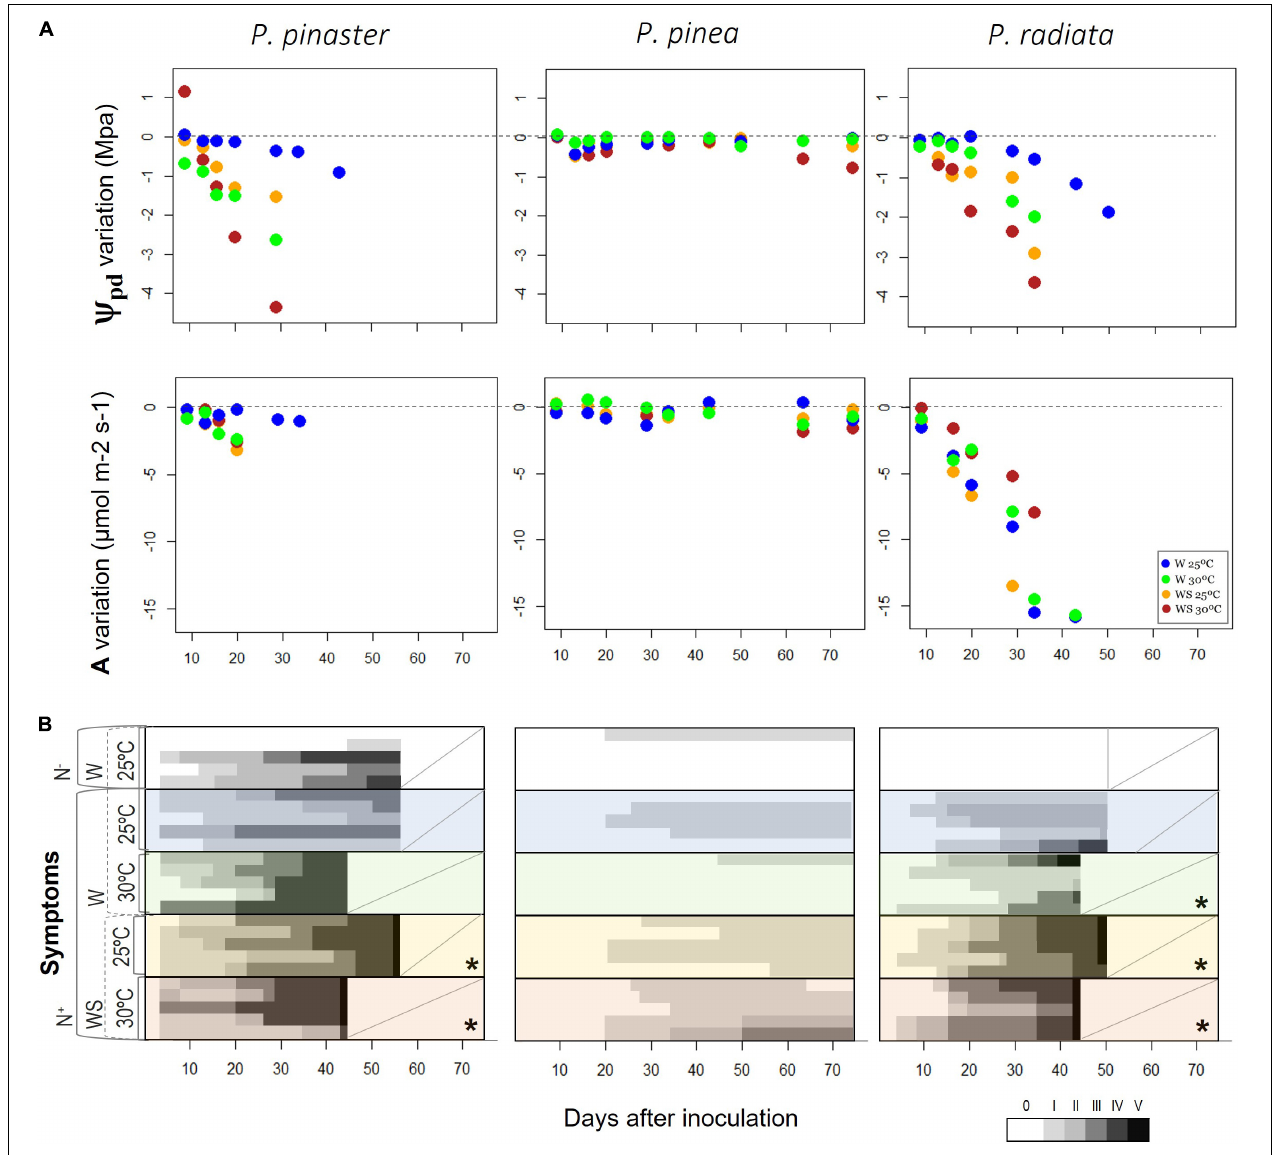
FIGURE 3 | Variation over time of main physiological variables and visible symptoms. (A) Pre-dawn water potential ( (cid:57) pd ) and carbon assimilation (A) from the controlled abiotic conditions to the respective inoculated treatment, i.e., the difference of (cid:57) pd and A between the inoculated treatments and the associated control (W25: N– vs. N+, WS25: N– vs. N+, W30: N– vs. N+, WS30: N– vs. N+) and (B) wilting symptoms after inoculation. Classification of wilting symptoms based on six scaled classes: 0 – tree without symptoms; I – < 10% brown leaves; II – 10–50% brown leaves; III – 50–80% brown leaves; IV – > 80% brown leaves; V – dead tree without leaves (Proença et al., 2010). An asterisk represents the presence of severe symptoms, with plants reaching death. A diagonal line indicates that the trial was finished, and the trees were removed. See section “Materials and Methods” for detailed information about each treatment and respective